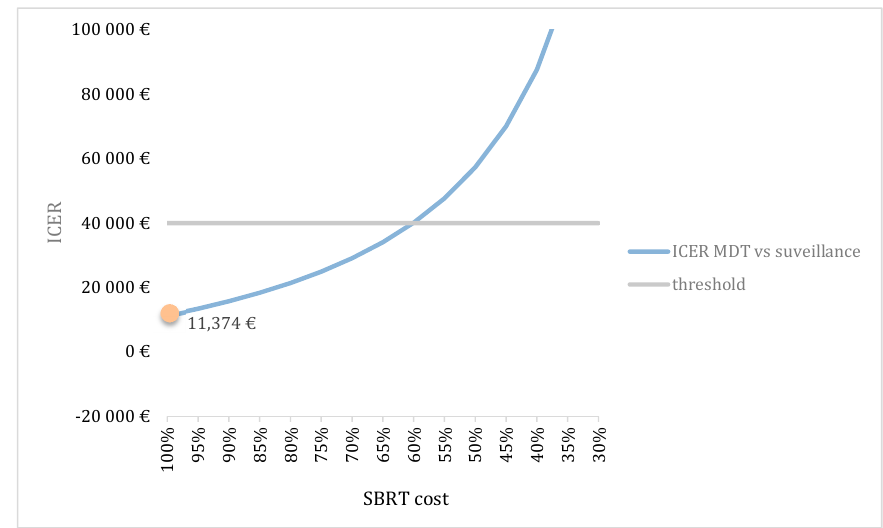
Figure 6. Scenario analysis investigating ICER in function of the effect of MDT versus surveillance. 100% is the effect as it was observed in the STOMP trial (orange dot). As seen in the figure, the ICER becomes higher when the difference in the effect of MDT versus surveillance becomes smaller. ICER: Incremental cost-effectiveness ratio; MDT: Metastasis-directed therapy.